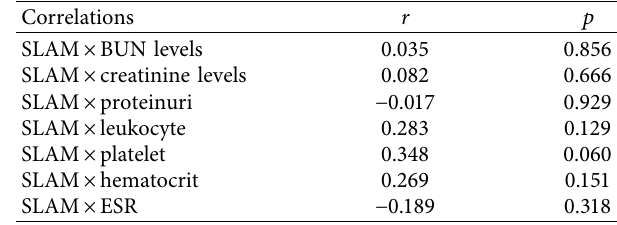
Table 2: Association of disease activity with renal damage and hematological activity.